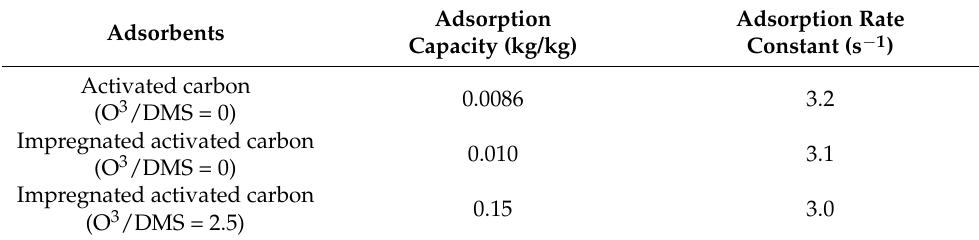
Table 4. The calculated values of adsorption capacity and adsorption rate